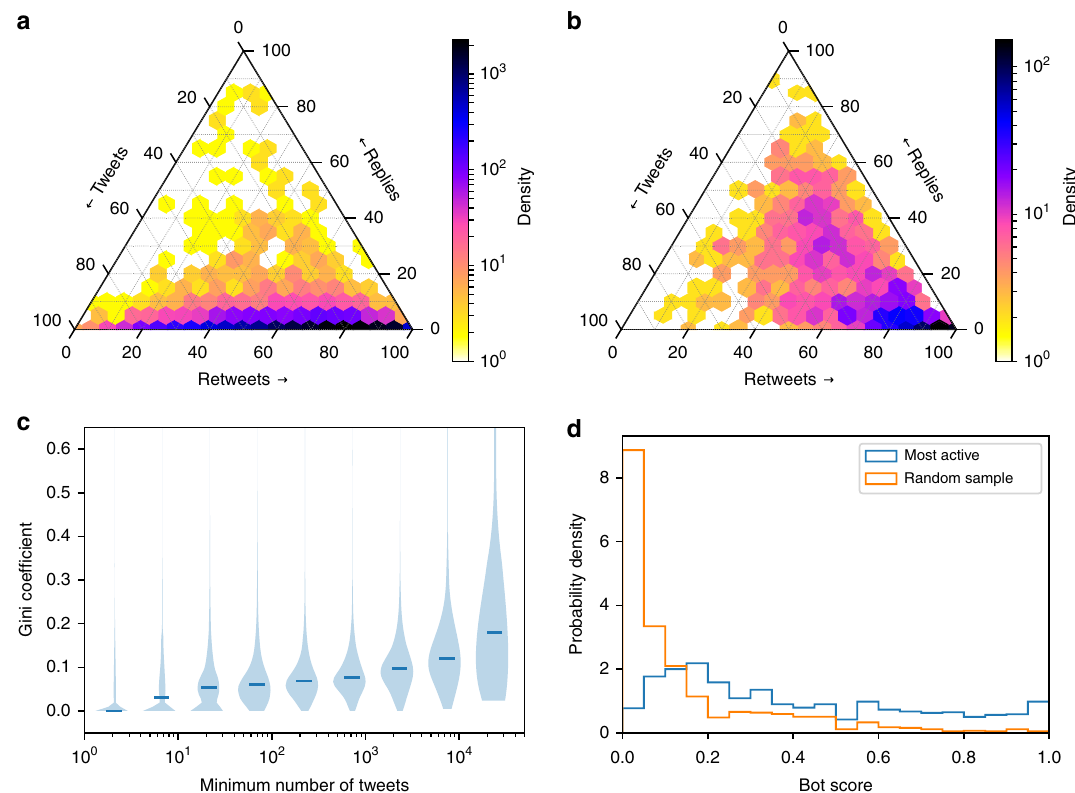
Fig. 2 Anomalies. The distribution of types of tweet spreading articles from a low-credibility and b fact-checking sources are quite different. Each article is mapped along three axes representing the percentages of different types of messages that share it: original tweets, retweets, and replies. When user Alice retweets a tweet by user Bob, the tweet is rebroadcast to all of Alice ’ s followers, whereas when she replies to Bob ’ s tweet, the reply is only seen by Bob and users who follow them both. Color represents the number of articles in each bin, on a log scale. c Correlation between popularity of articles from low- credibility sources and concentration of posting activity. We consider a collection of articles shared by a minimum number of tweets as a popularity group. For articles in each popularity group, a violin plot shows the distribution of Gini coef fi cients which measure concentration of posts by few accounts (see Supplementary Methods). In violin plots, the width of a contour represents the probability of the corresponding value, and the median is marked by a colored line. d Bot score distributions for a random sample of 915 accounts who posted at least one link to a low-credibility source (orange), and for the 961 “ super-spreaders ” that most actively shared content from low-credibility sources (blue). The two groups have signi fi cantly different scores ( p < 10 −